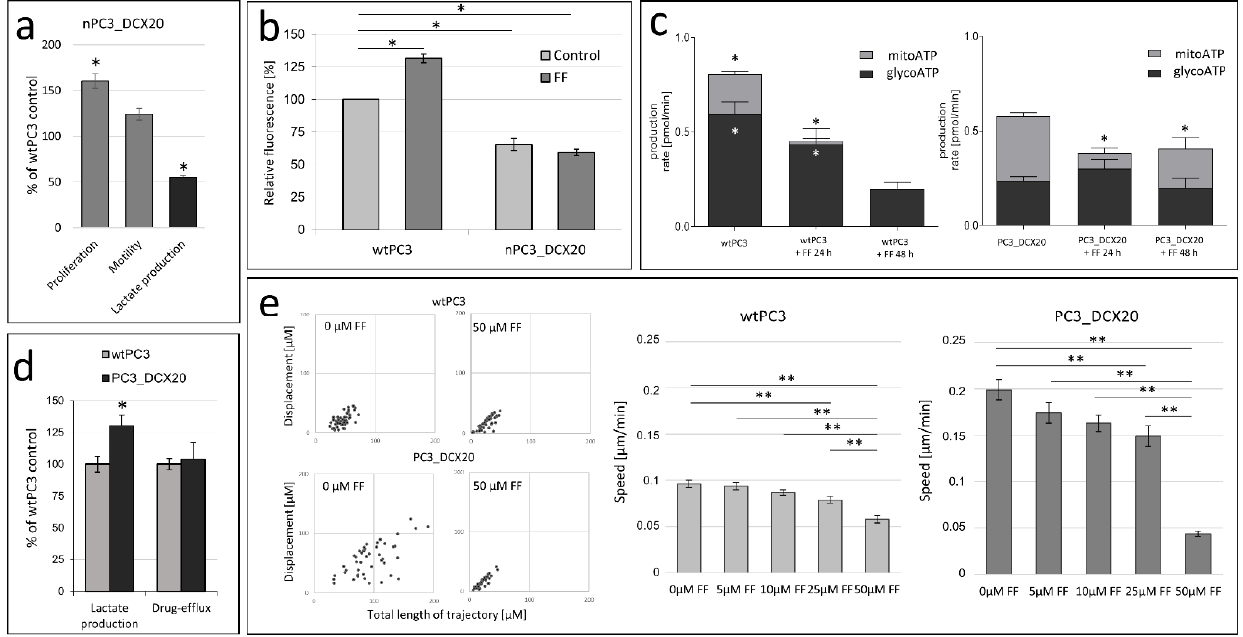
Figure 1. Loss of drug resistance does not attenuate PC3 sensitivity to fenofibrate. ( a ) Relative proliferation, motile activity and lactate production in native PC3_DCX20 populations calculated with the Coulter counter, time-lapse videomicroscopy and lactate production assay, respectively, in relation to the wtPC3 control. ( b ) Effect of 25 μ M FF on the relative calcein levels in calcein-loaded populations of wtPC3 and native (n)PC3_DCX20 cells (cf. Figure S1a). ( c ) Effect of 25 μ M FF on the metabolic profile of wtPC3 ( left ) and nPC3_DCX20 cells ( right ). Analyses of mitochondrial and glycolytic ATP production (mitoATP and glycoATP, respectively) were based on Seahorse analyses of oxygen consumption rate (OCR) and extracellular acidification rate (ECAR), respectively. ( d ) Lactate production and drug efflux intensity in wtPC3 and long-term expanded PC3_DCX20 cells. ( e ) Motility of wtPC3 ( left ) and PC3_DCX20 cells ( right ) in the contol conditions and in presence of FF (5, 10, 25 or 50 µ M). Column charts show averaged rate of cell movement calculated at the population level (N > 40). The statistical significance of the differences was estimated with the use of Student’s t -test ( a – d ) or Kruskal–Wallis test ( e ). * p < 0.05; ** p ≤ 0.01. Note the retroevolution of nPC3_DCX20 cells towards the low drug efflux phenotype and the low FF tolerance of PC3_DCX20